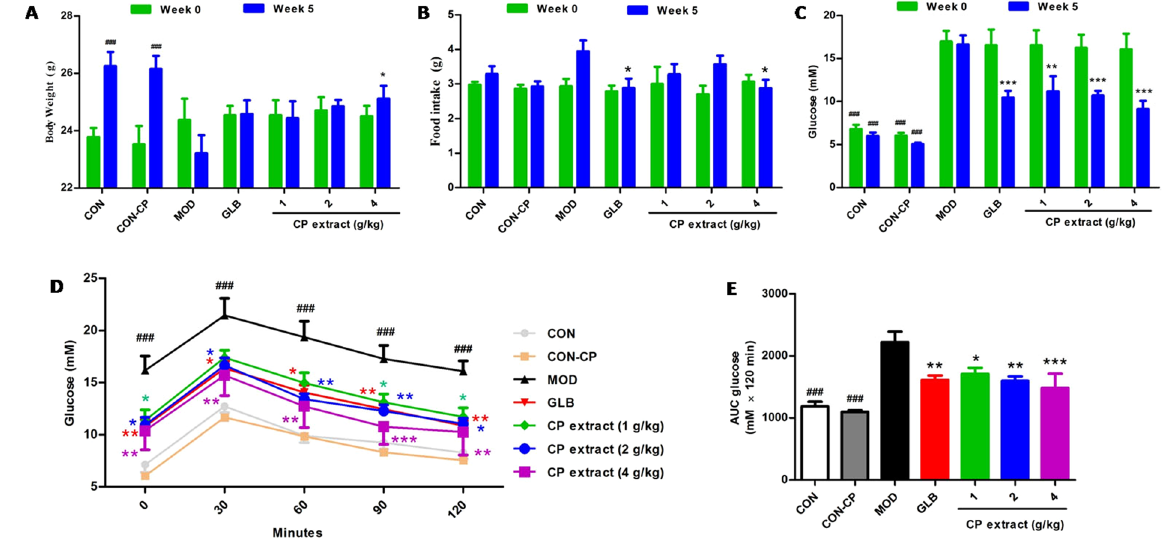
Figure 1. CP extract alleviates STZ and high fat-induced diabetes in mice. The type 2 diabetic mice were induced by feeding with high-fat diet for 4 weeks and then injecting intraperitoneally with 25 mg/kg STZ for 3 days consecutively. The diabetic mice with consecutive 7-day hyperglycemia (11 mmol/L or greater) were selected for the experiment and then CP extract or glibenclamide were administered to mice for consecutive 5 weeks. During the experiment, the body weight, food intake and blood glucose levels of mice were monitored weekly. The body weight on week 0 and 5 at checkpoint after the initiation of CP extract treatment respectively ( A ); The food intake on week 0 and 4 at checkpoint after the initiation of CP extract treatment respectively ( B ); The blood glucose levels on week 0 and 5 at checkpoint after the initiation of CP extract treatment respectively ( C ). The blood glucose levels ( D ) and the areas under curves (AUCs) constructed from blood glucose levels ( E ) of oral glucose tolerance test (OGTT) on week 4 at checkpoint after the initiation of CP extract treatment. The blood glucose levels in serum were determined by a glucometer (OMRON (China) Co., Ltd, Beijing, China). All data are presented as means ± SEM (n = 8). # p < 0.05, ## p < 0.01 and ### p < 0.001, diabetic model group compared with non-diabetic groups; * p < 0.05, ** p < 0.01 and *** p < 0.001, compared with diabetic model